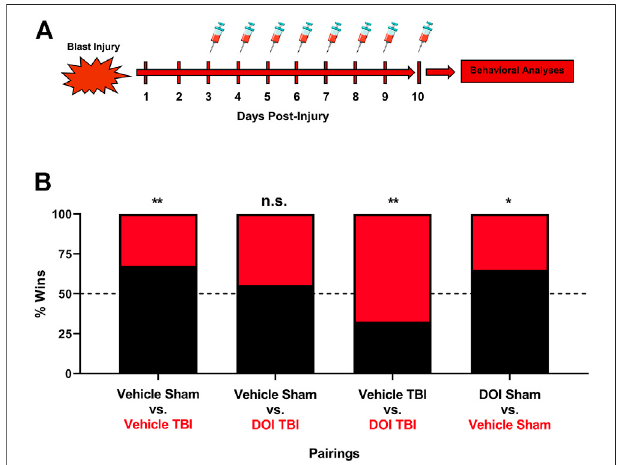
FIGURE 4 | Repeated pharmacologic 5-HT 2A receptor activation ameliorates mTBI-elicited de fi cits in social dominance. (A) Low-dose DOI administration (0.1 mg/kg, (I) p., QD) was initiated three days post-injury or sham procedures, a time point where increased 5-HT 2A receptor sensitivity is noted following mTBI. (B) One hour post-DOI administration 10 days post-injury, subjects were paired off in the tube test for social dominance. Again, we found that mTBI subjects administered vehicle exhibited areduction in socialdominance 10 days post-injuryascomparedto their sham counterparts (vehicle sham vs. vehicle mTBI, Fisher ’ s Exact Test, ** p ≤ 0.01, N = 12/group). DOI administration in mTBI subjects attenuated social dominance de fi cits when compared to their sham vehicle administered counterparts (vehicle sham vs DOI mTBI, Fisher ’ s exact test, n. s., N = 12/ group). Furthermore, mTBI subjects administered DOI exhibit a signi fi cant increase in social dominance behavior as compared to their vehicle-treated mTBIcounterparts(vehiclemTBIvs.DOImTBI,Fisher ’ sexacttest,** p ≤ 0.01, N = 12/group). It should be noted that DOI administration in sham